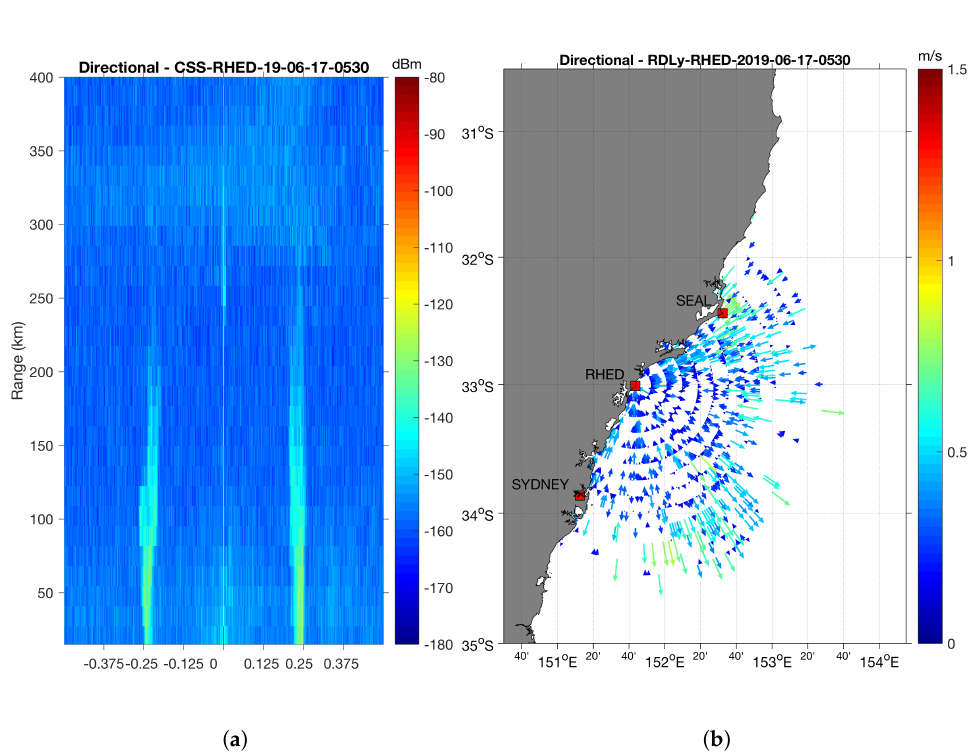
Figure 12. Range Doppler spectrum for receiver channel 3 ( a ) collected while using the directive transmit antenna at Red Head SeaSonde station, coloured to show signal power (in dBm) at range (in km) vs. frequency (in Hz). The corresponding radial velocity map ( b ). No quality control is applied to this preliminary output radial velocity data. Bandwidth was 11.028 kHz, corresponding to a radial range resolution of 13.591 km.